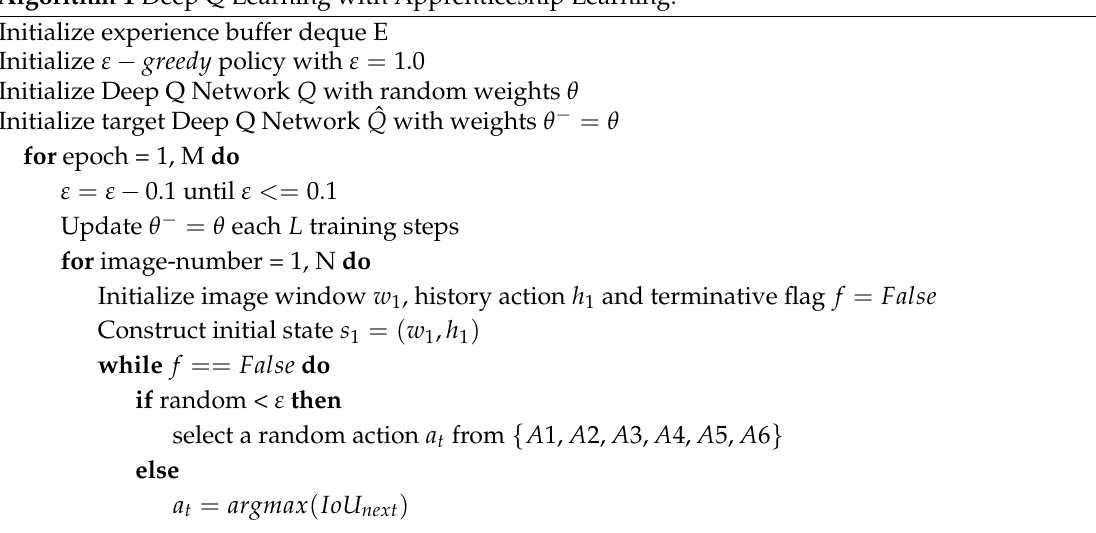
Algorithm 1 Deep Q Learning with Apprenticeship